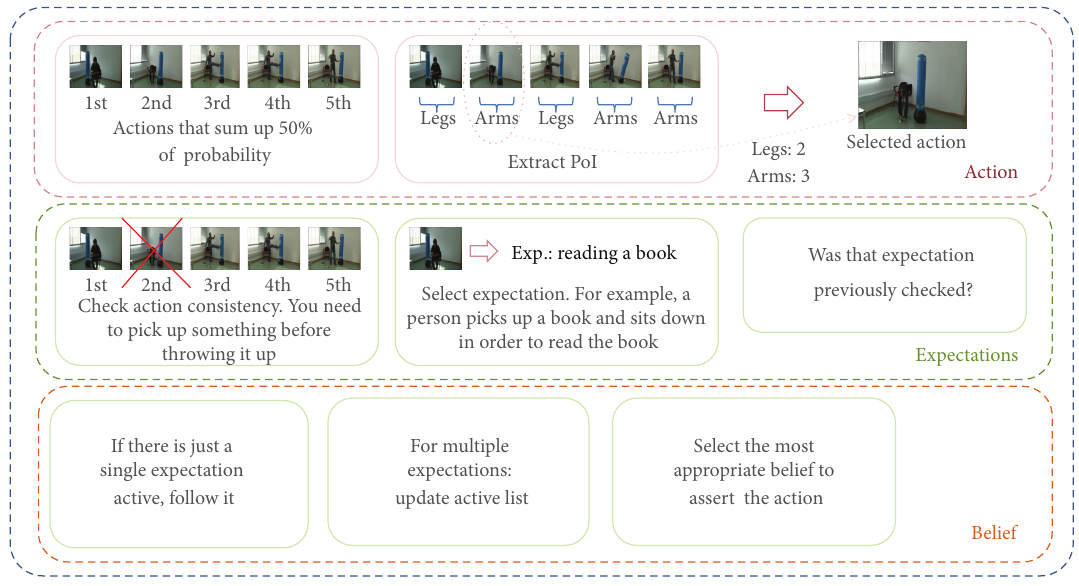
Figure 4: High level stages involved in the reasoning